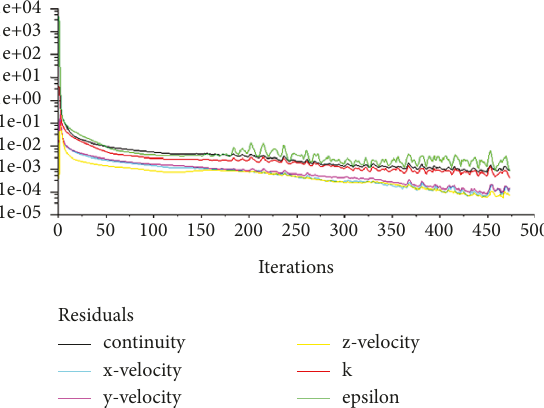
Figure 8: Residual curve of the plastic centrifugal